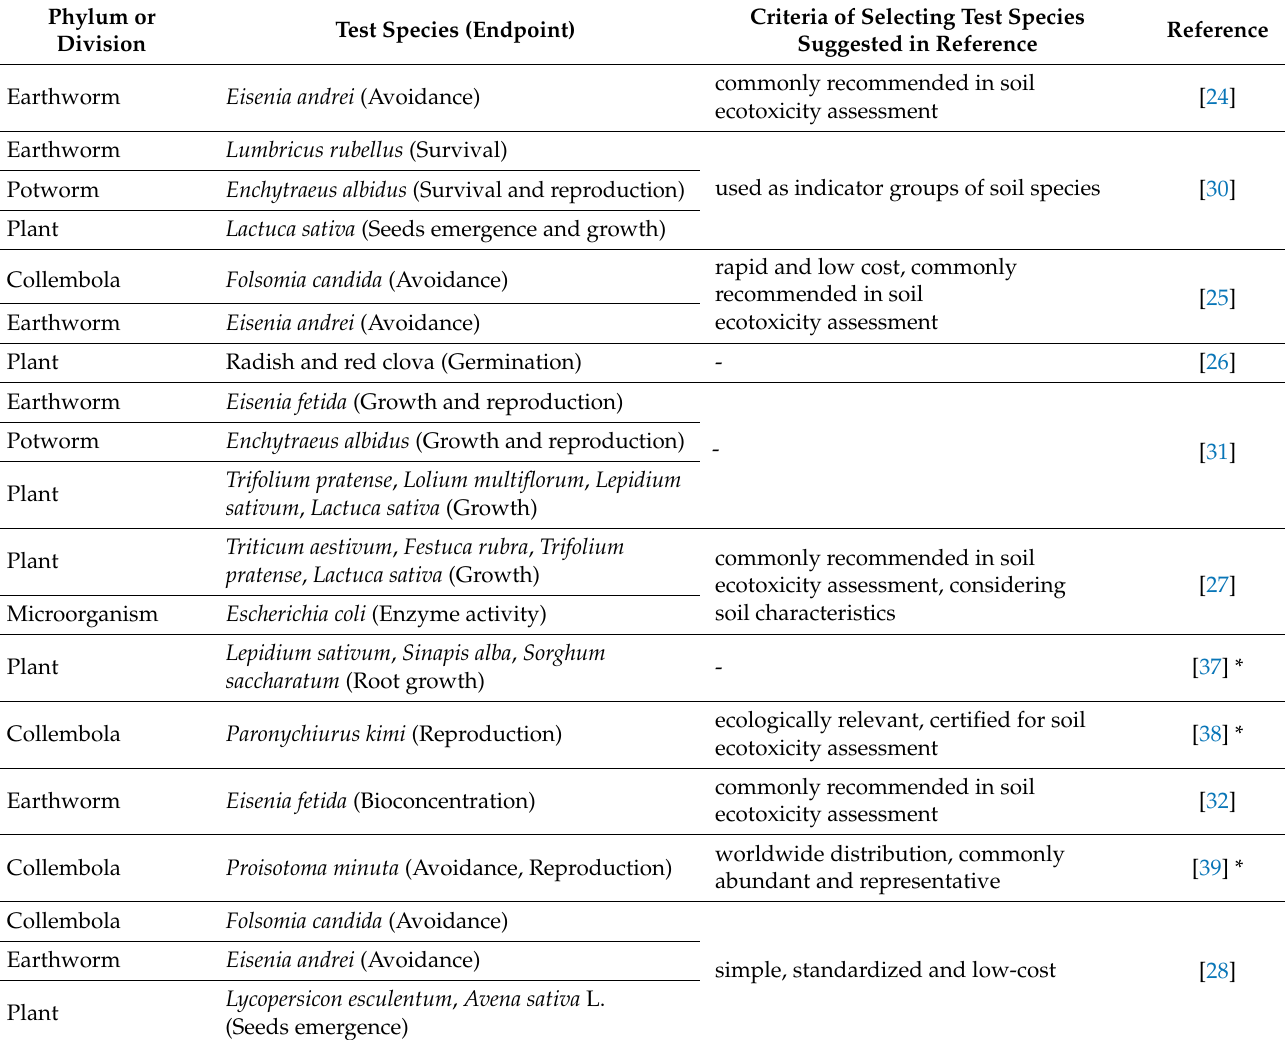
Table 3. Summary of previous studies on the criteria for selecting test species for the screening of site-specific soil ecological risk assessments (SERAs). The asterisk (*) indicates research that performed bioassays using only one test media. Phylum